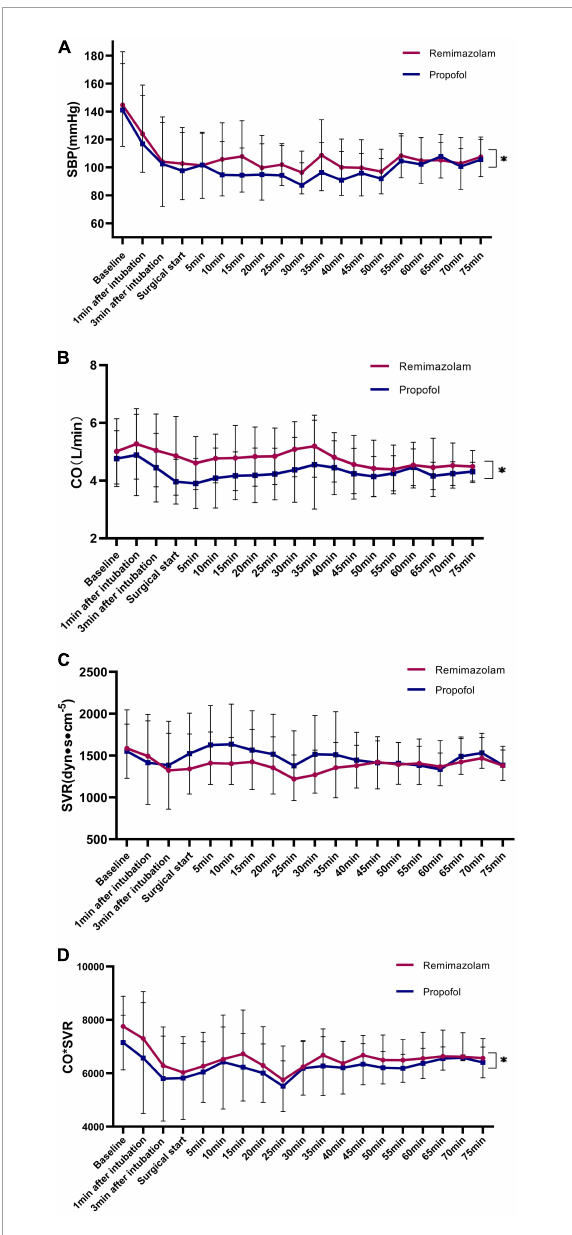
FIGURE4 Trends of hemodynamic variables during surgery: (A) SBP; (B) CO; (C) SVR; (D) the product of CO and SVR. Data are presented as mean with error bars showing SD. Trends of SBP, CO, SVR, and the product of CO showing significant difference between groups ( ∗ p < 0.05). SBP, systolic blood pressure; CO, cardiac output; SVR, systolic vascular resistance; SD, standard